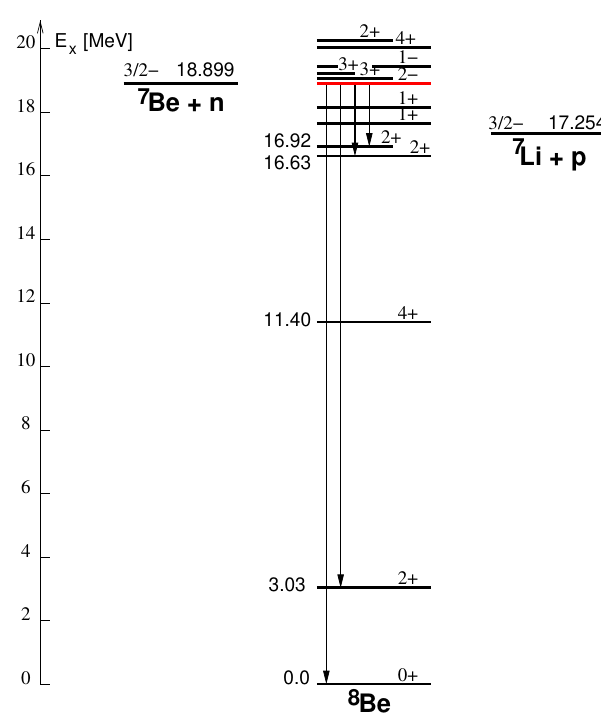
Figure 1. Energy levels of 8 Be in the energy range of interest for the present work.